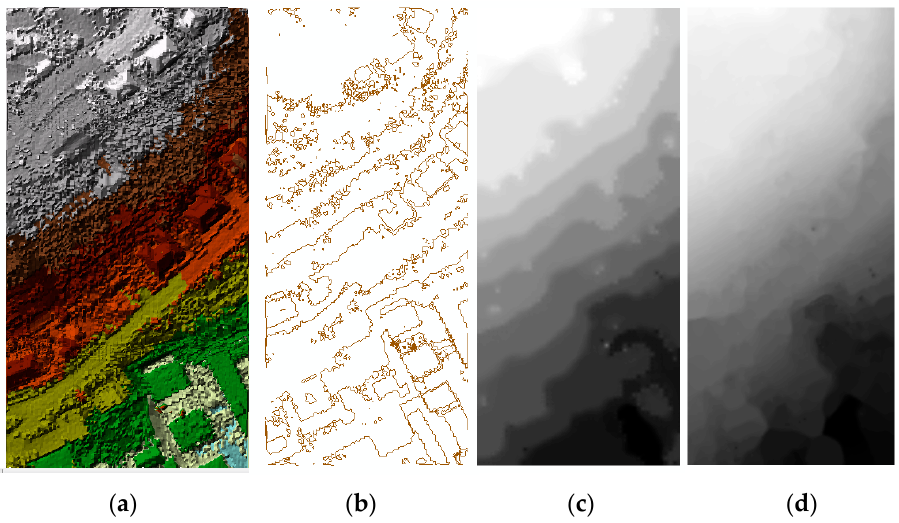
Figure 10. ( a ) slant area: International Society of Photogrammetry and Remote Sensing (ISPRS) sample 11, ( b ) extracted contour lines from a triangulation irregular network (TIN) model, ( c ) extracted DEM, ( d ) reference DEM.